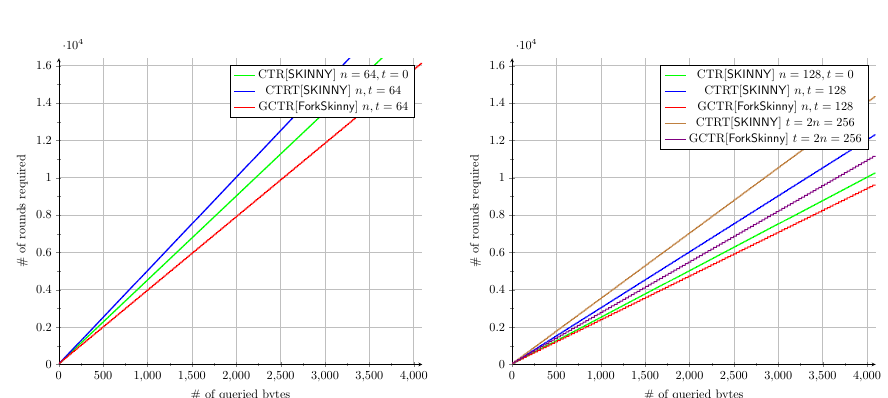
Figure 4: Efficiency comparison of any GCTR[ ForkSkinny ] (with s = 2) with CTR[ SKINNY ] and CTRT[ SKINNY ] modes. These plots show the number of rounds required to process the queried bytes ( snσ/ 8). The left figure corresponds to the input size n = 64 bits whereas the right figure corresponds to the input size n = 128 bits.